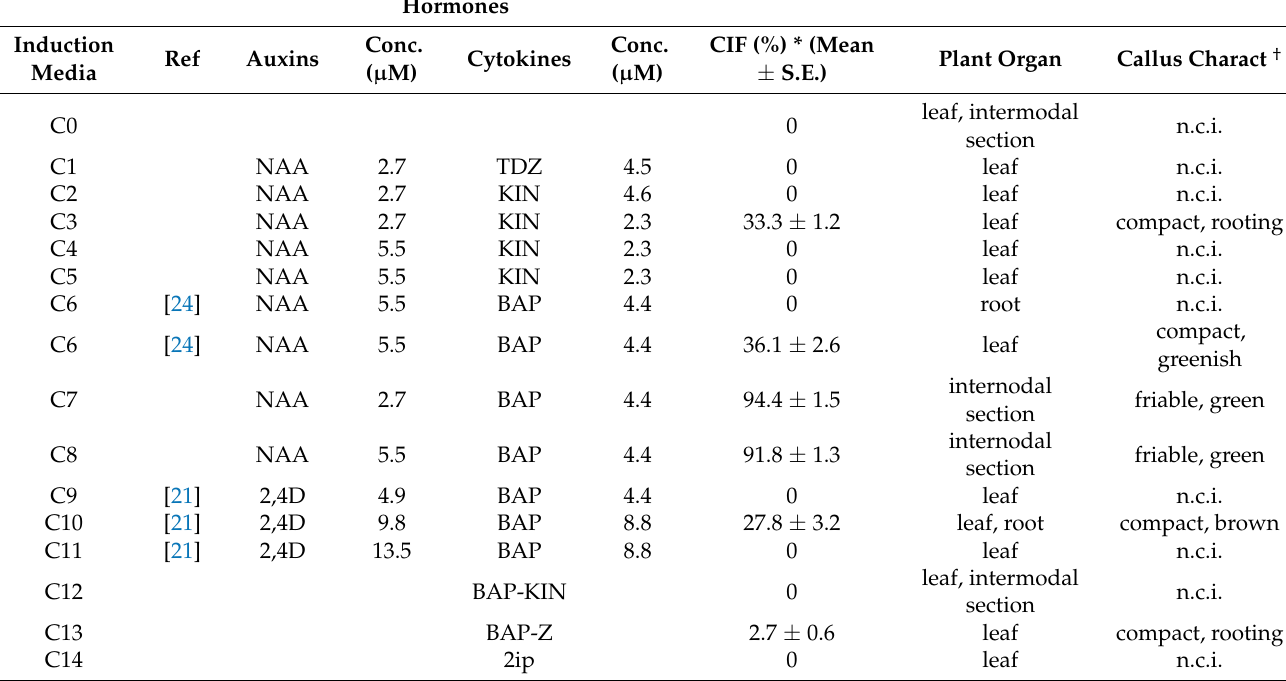
Table 2. Medium composition for Leptocarpha rivularis callus induction. Different combinations of auxins and cytokines were used: 1-naphthaleneacetic acid (NAA), 6-benzylaminopurine (BAP), isopentenyl adenine (2ip), kinetin (KIN), thidiazuron (TDZ), zeatin (Z). n.c.i.: no callus